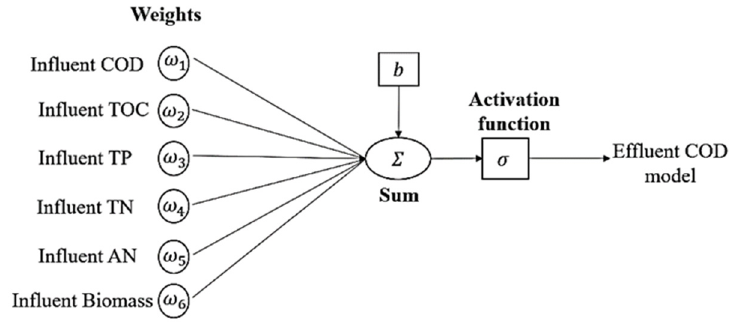
Figure 3. Single neuron of neural network with multiple inputs used.